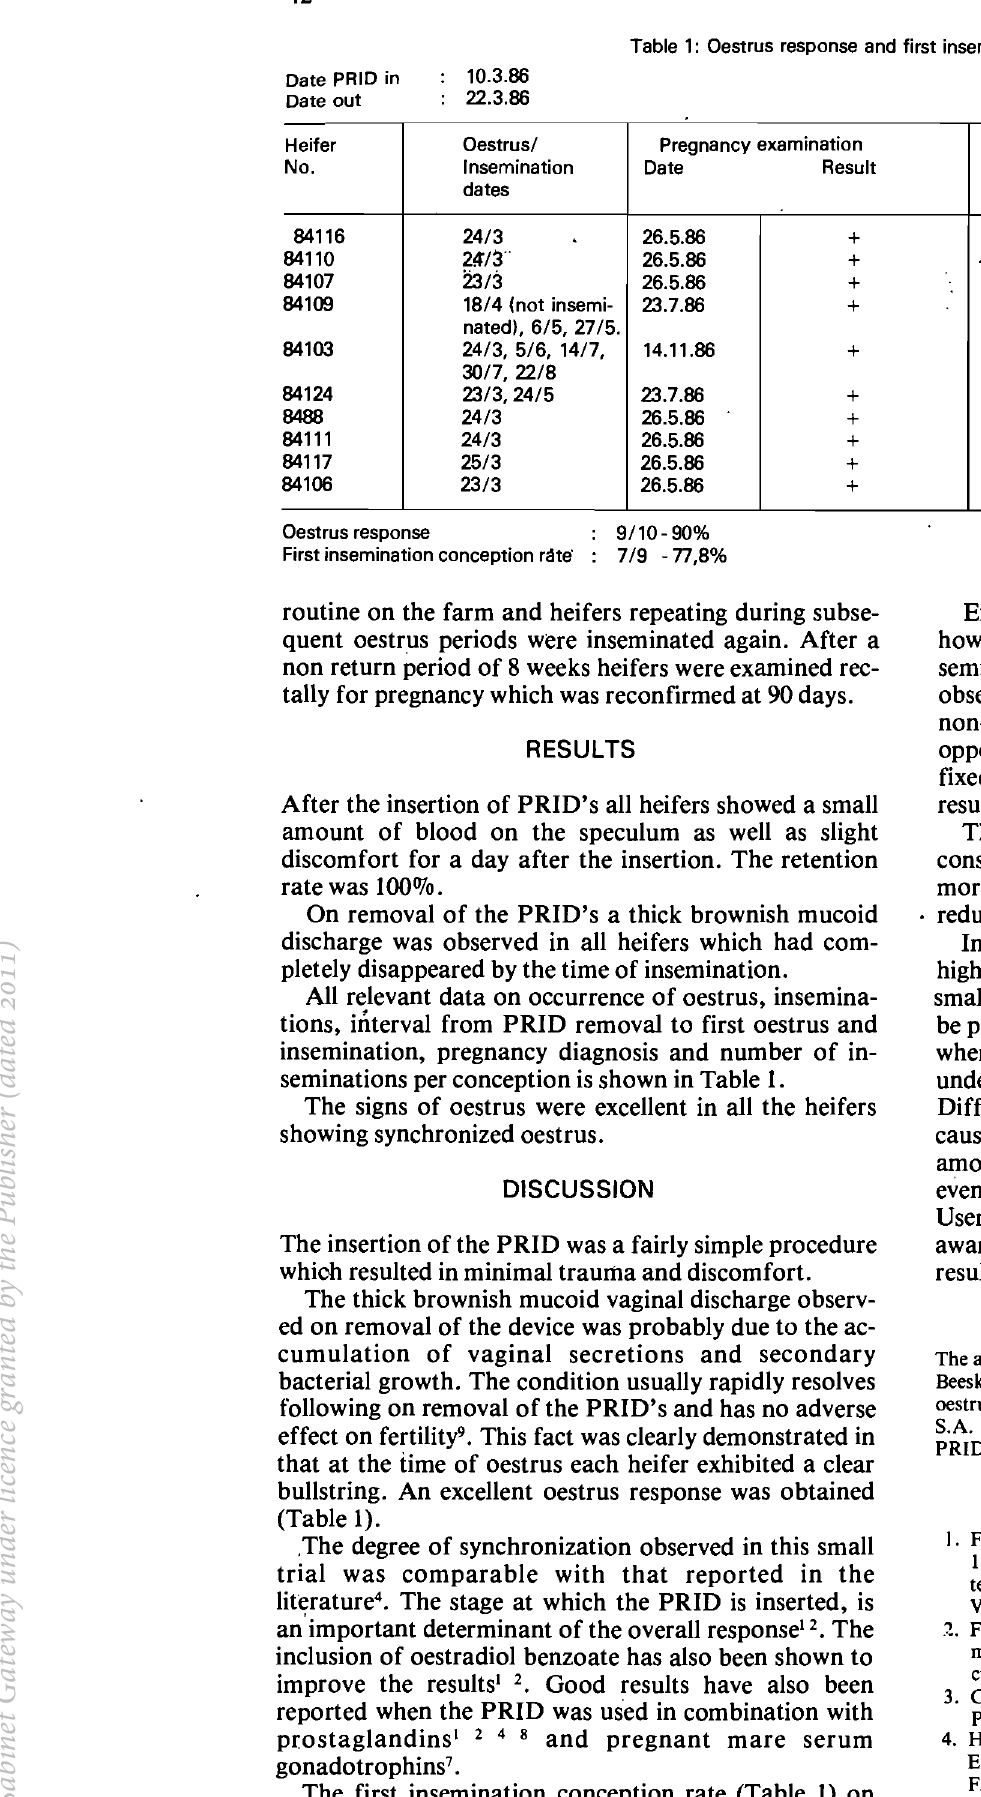
Table 1: Oestrus response and first insemination conception